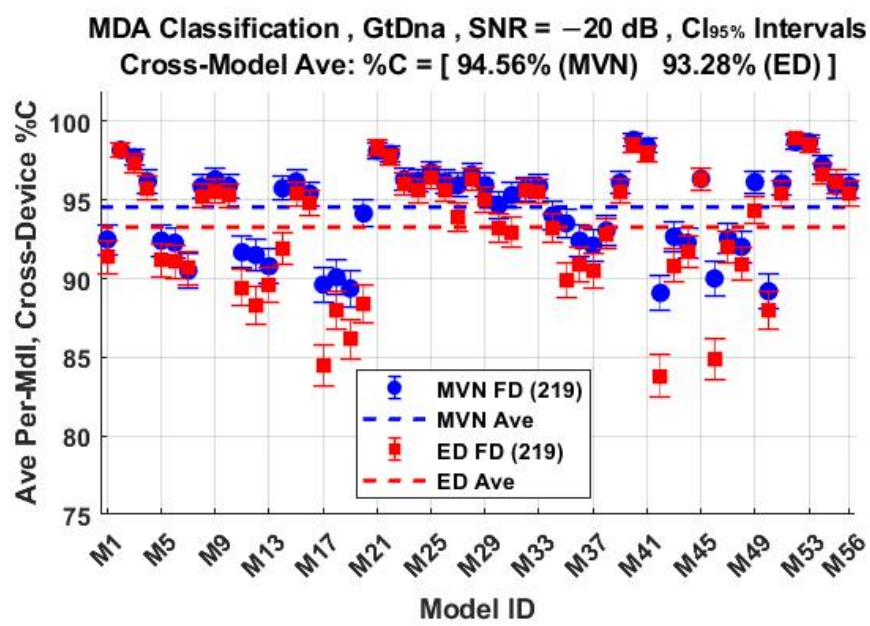
Figure 12. Per-model MDA classification performance for the N Mdl = 56 models in Table 2. Results are for full-dimensional N FD-GT = 219 features generated under SNR = − 20 dB conditions using ED ( ■ ) and MVN ( ● ) measures of similarity.